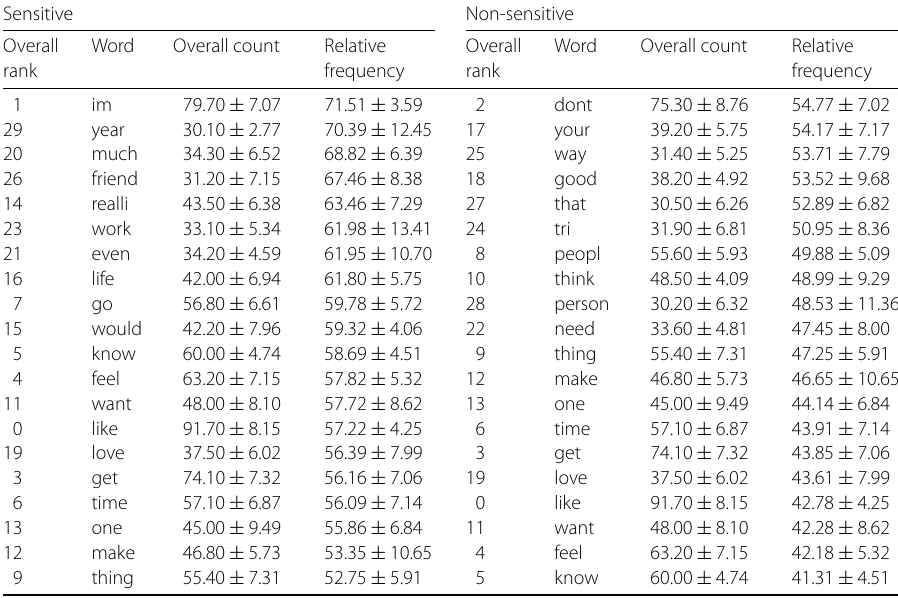
Table 7 Most relevant words for each class in dataset OMC Sensitive Non-sensitive Overall rank